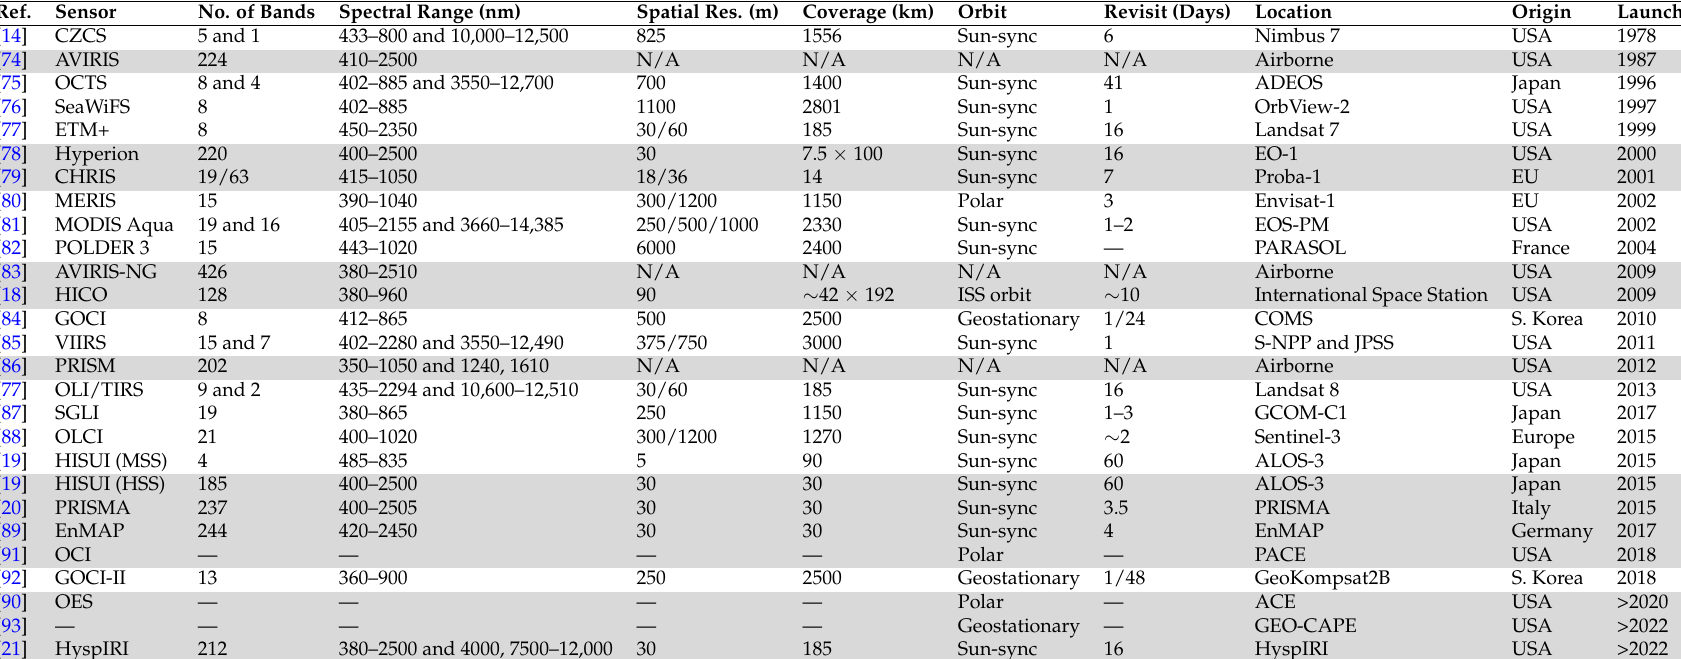
Table 1. Multispectral and hyperspectral ocean colour remote sensors. The table shows how there is a trend towards hyperspectral sensors (grey) and an increase in spectral and spatial resolution. Geostationary orbits will also provide an increase in temporal resolution. Key: —, Not known at the time of submission; Spatial Res., Spatial Resolution; CZCS, Coastal Zone Color Scanner; AVIRIS, Airborne Visible/Infrared Imaging Spectrometer; OCTS, Ocean Color and Temperature Scanner; SeaWiFS, Sea-viewing Wide Field-of-View Sensor; ETM+, Enhanced Thematic Mapper Plus; CHRIS, Compact High Resolution Imaging Spectrometer; MERIS, Medium-Resolution Imaging Spectrometer; MODIS, Moderate-Resolution Imaging Spectroradiometer; POLDER, Polarization and Directionality of the Earth’s Reflectances; NG, Next Generation; HICO, Hyperspectral Imager for the Coastal Ocean; GOCI, Geostationary Ocean Color Imager; VIIRS, Visible Infrared Imaging Radiometer Suite; PRISM, Portable Remote Imaging Spectrometer; OLI, Operational Land Imager; TIRS, Thermal Infrared Sensor; SGLI, Second Generation Global Imager; OLCI, Ocean and Land Colour Instrument; HISUI, Hyperspectral Imager Suite; MSS, Multi Spectral Sensor; HSS, Hyper Spectral Sensor; PRISMA, Precursore Iperspettrale della Missione Operativa; EnMAP, Environmental Mapping and Analysis Program; OCI, Ocean Color Instrument; OES, Ocean Ecology Sensor; HyspIRI, Hyperspectral Infrared Imager; ADEOS, Advanced Earth Observing Satellite; EO, Earth Observing; EOS, Earth Observing System; PARASOL, Polarization and Anisotropy of Reflectances for Atmospheric science coupled with Observations from a Lidar; COMS, Communication, Ocean and Meteorological Satellite; S-NPP, Suomi National Polar-orbiting Partnership; JPSS, Joint Polar Satellite System; GCOM, Global Change Observation Mission; ALOS, Advanced Land Observation Satellite; PACE, Pre-Aerosol, Clouds and Ocean Ecosystem; ACE, Aerosol Cloud Ecosystem; GEO-CAPE, Geostationary Coastal and Air Pollution